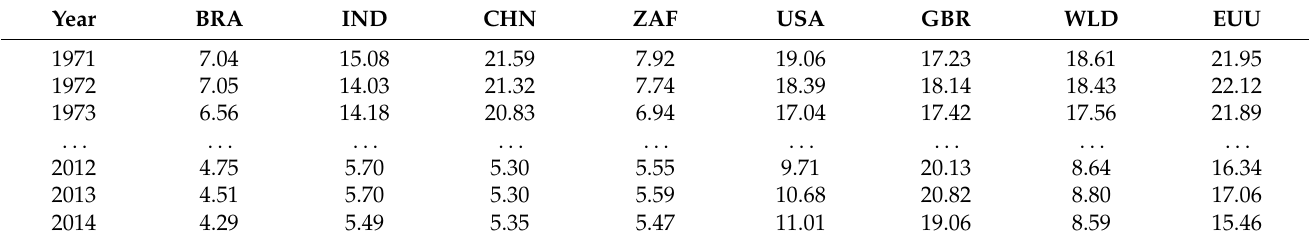
Table 1. Dataset of CO 2 emissions from buildings, expressed as a percentage of total fuel combustion, in Brazil (BRA), India (IND), China (CHN), South Africa (ZAF), the United States (USA), Great Britain (GBR), the world (WLD), and EUU (the European Union), covering the period between